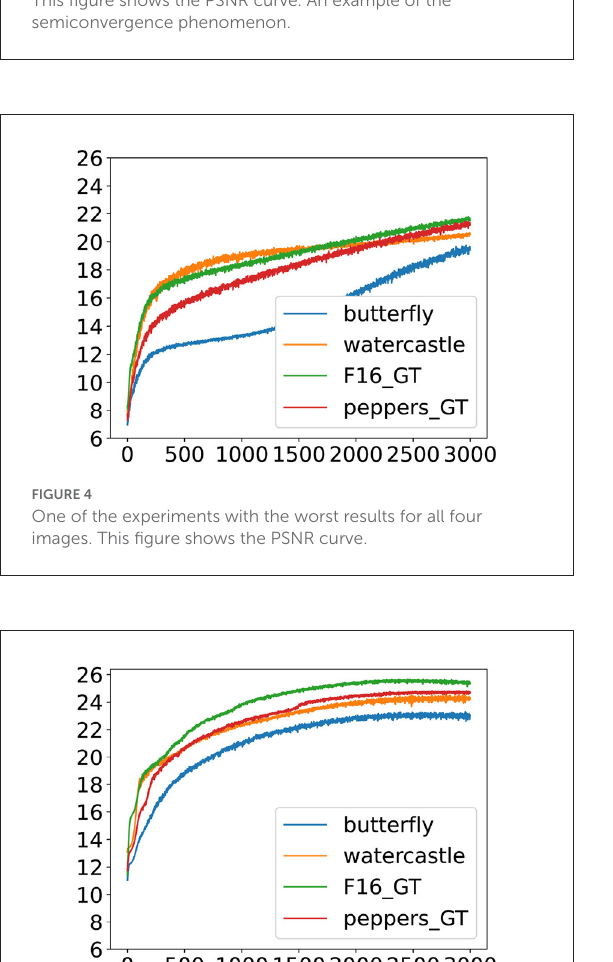
epochs. Both examples confirm what had already been observed in Table